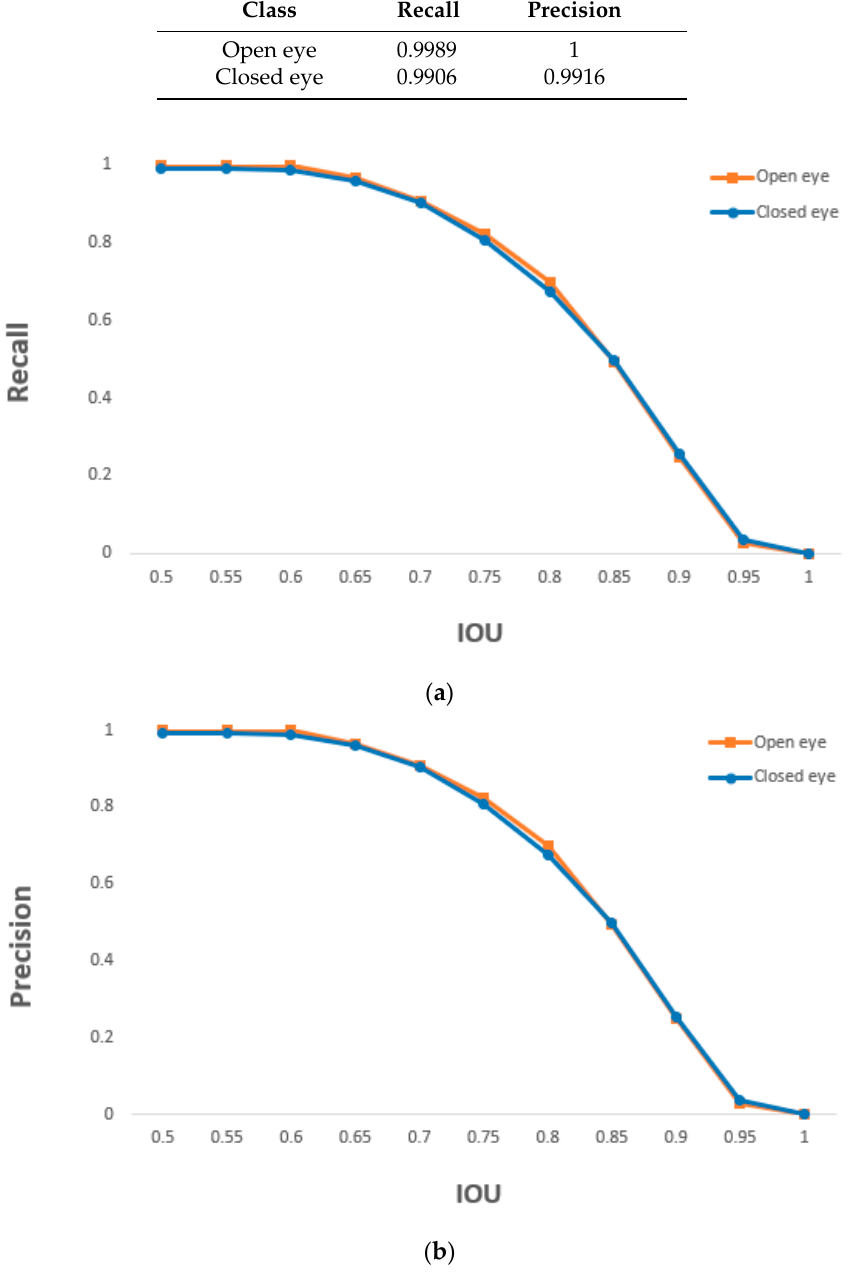
Table 8. Recall and precision for the detection of open and closed eye using the proposed method at an IOU threshold of 0.5.